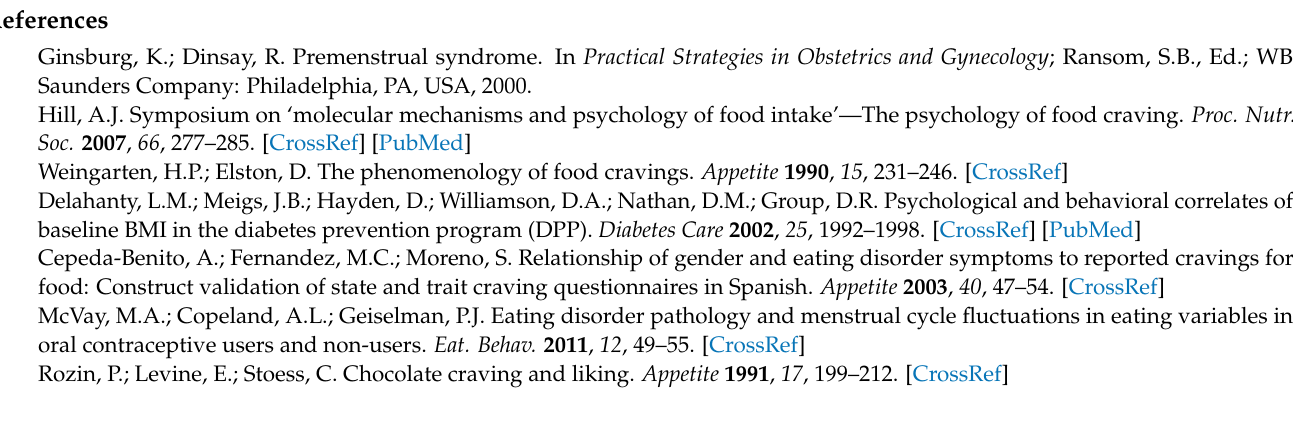
diagnosis; Table S4: Adjusted models evaluating premenstrual symptom relationships; Table S5: Ad- justed models evaluating the relationship between behavioral symptoms and functionality. Figure S1: QQ plots of the four models evaluating relationships between behavioral and affective/physiological premenstrual symptoms; Figure S2: QQ plots of the four models evaluating relationships between functionality and behavioral